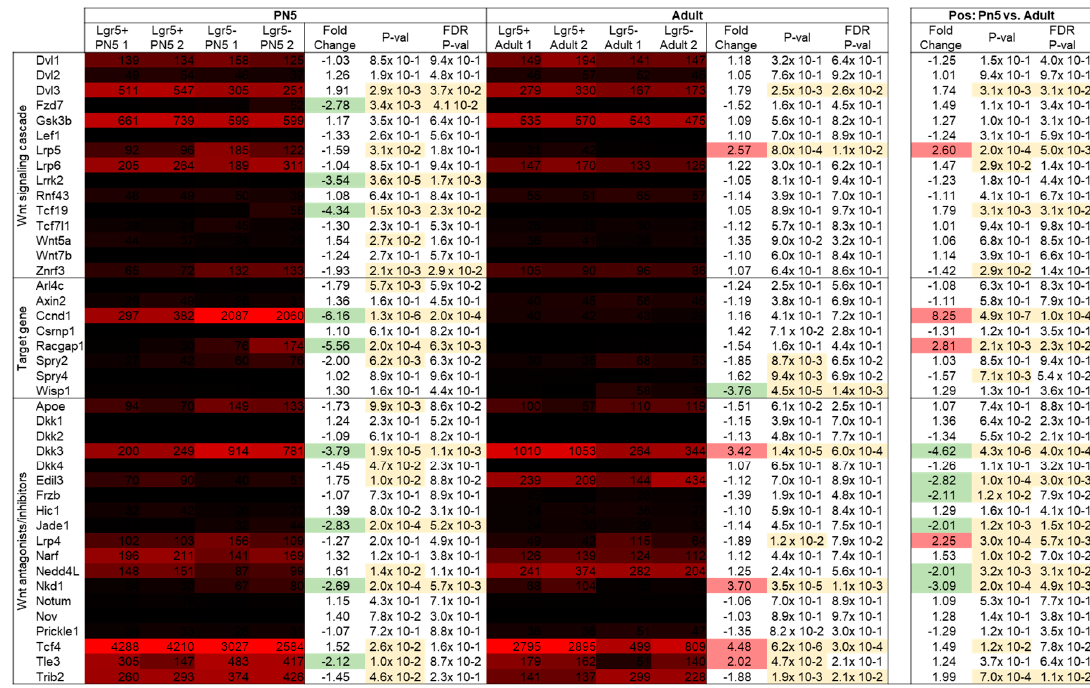
Figure 3. Gene expression levels and fold changes of Wnt-pathway members. Fold change shows lower expression of Wnt signaling genes at PN5 in Lgr5 + cells compared to Lgr5 − cells. Differentially expressed genes were defined by a fold change ≥ 2 or ≤ − 2, p -value < 0.05, and false discovery rate (FDR) < 0.05.